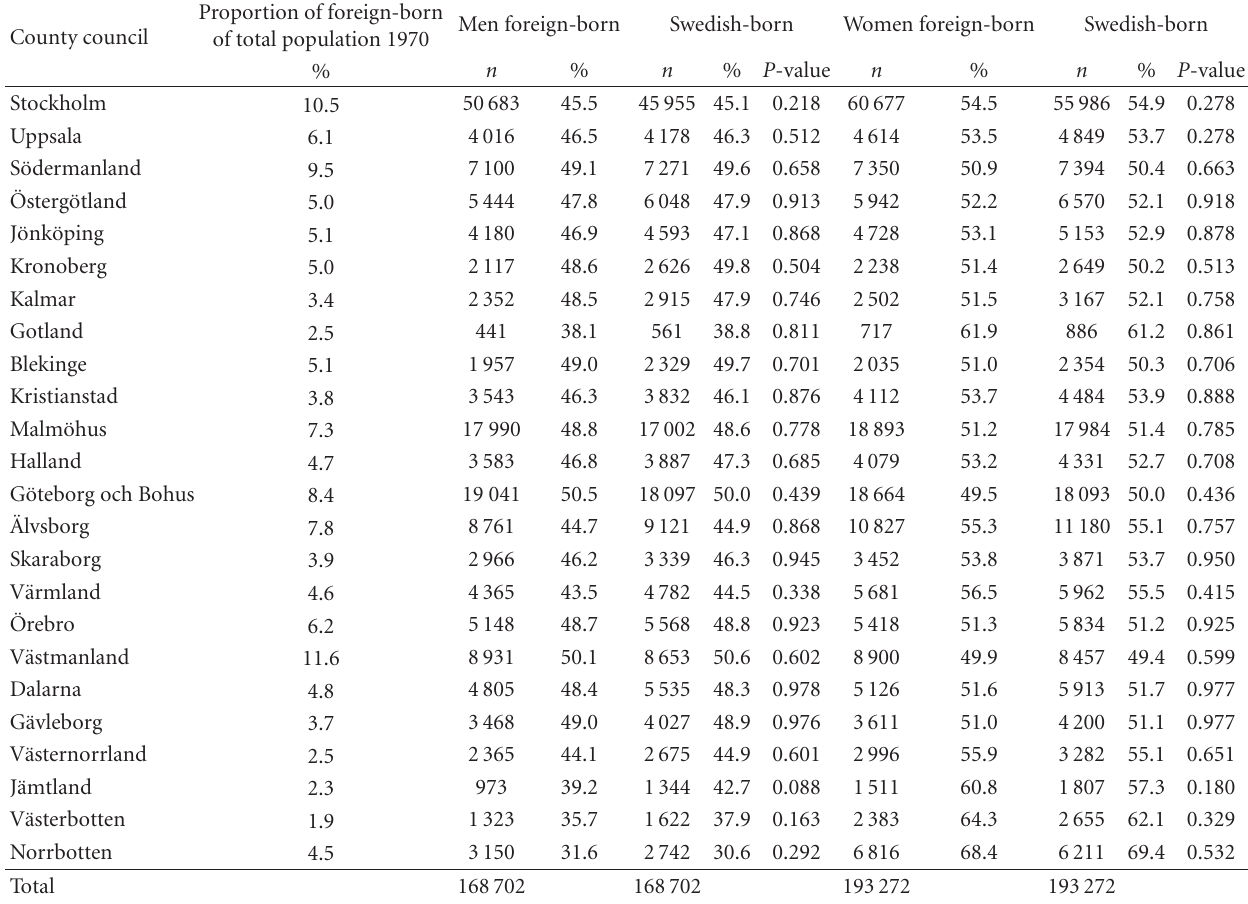
Table 2: Population in relation to sex and latest County Council of